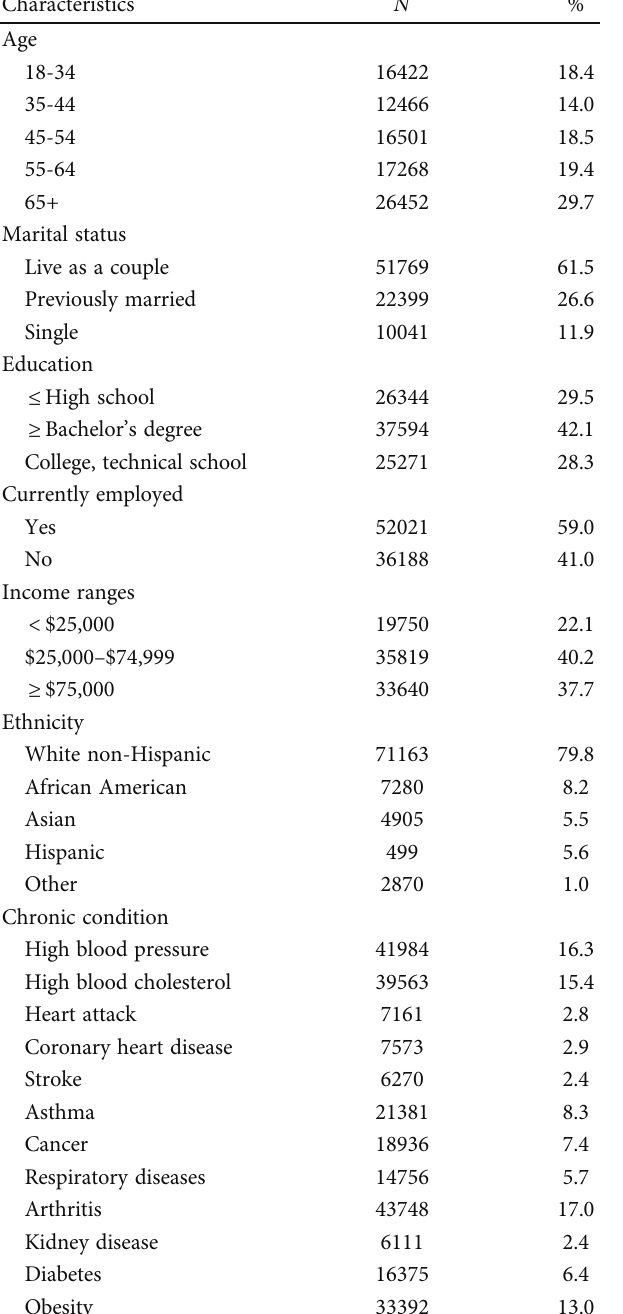
Table 1: The sociodemographic traits and persistent health issues of study participants ( N = 89209 ).